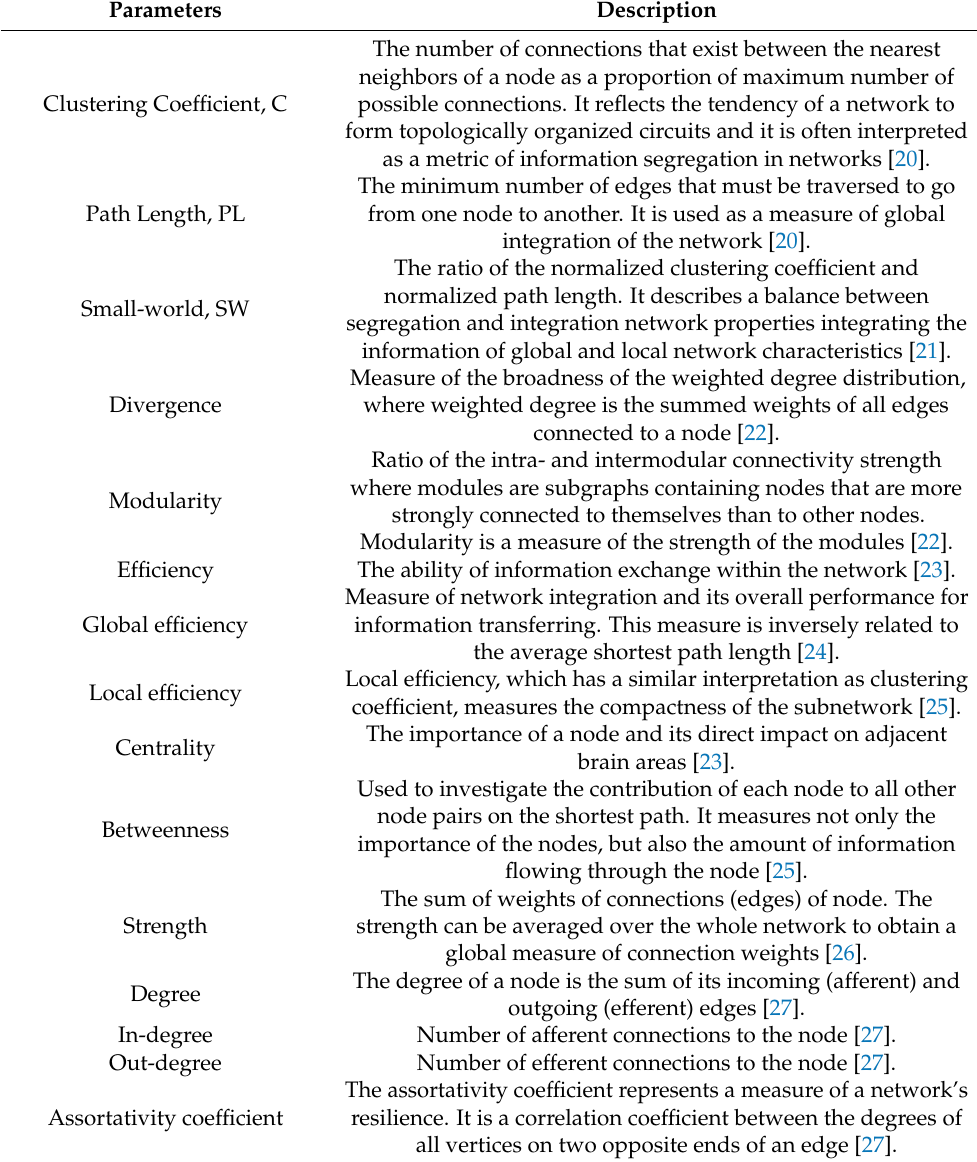
Table 1. Description of the main graph theory